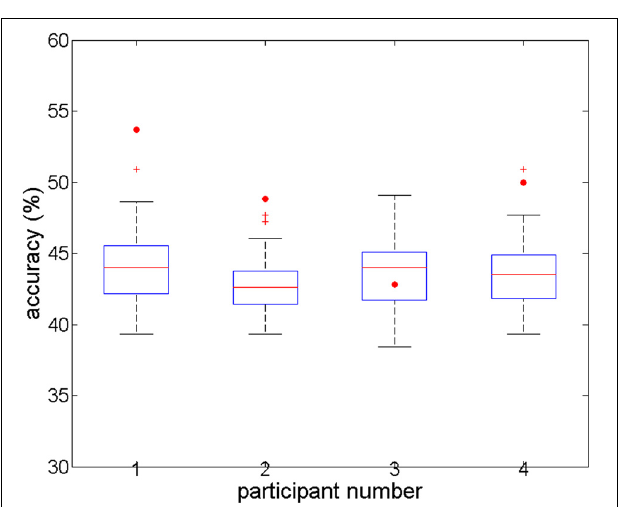
FIGURE 3 | Overall accuracies in the full-brain search analysis, for four subjects’ real and permuted data. For subjects 1, 2, and 4, prediction accuracy is significant ( p < 0 . 05; n = 100 permutations). For subject 3, there is no difference between real and permuted